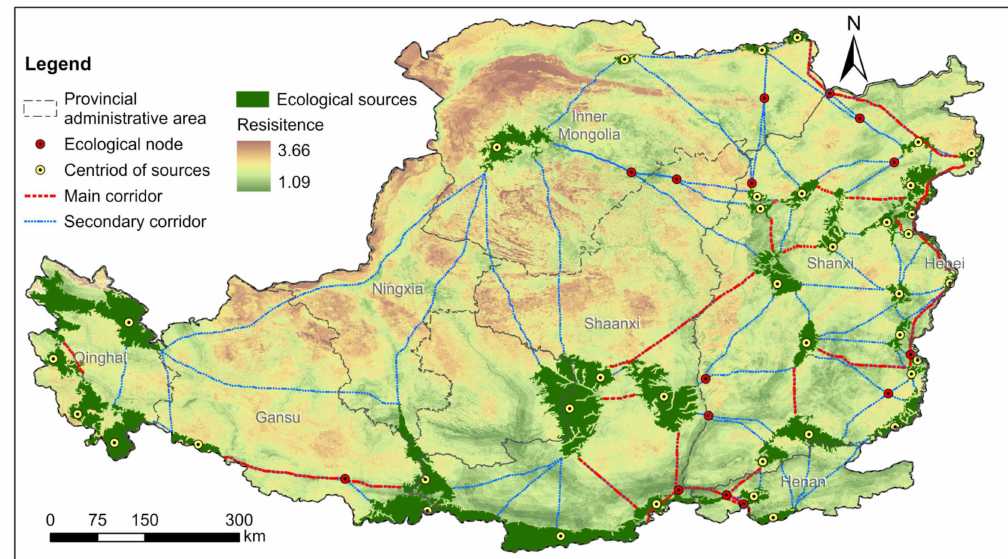
Figure 6. Construction results of ecological network structure in LPC.